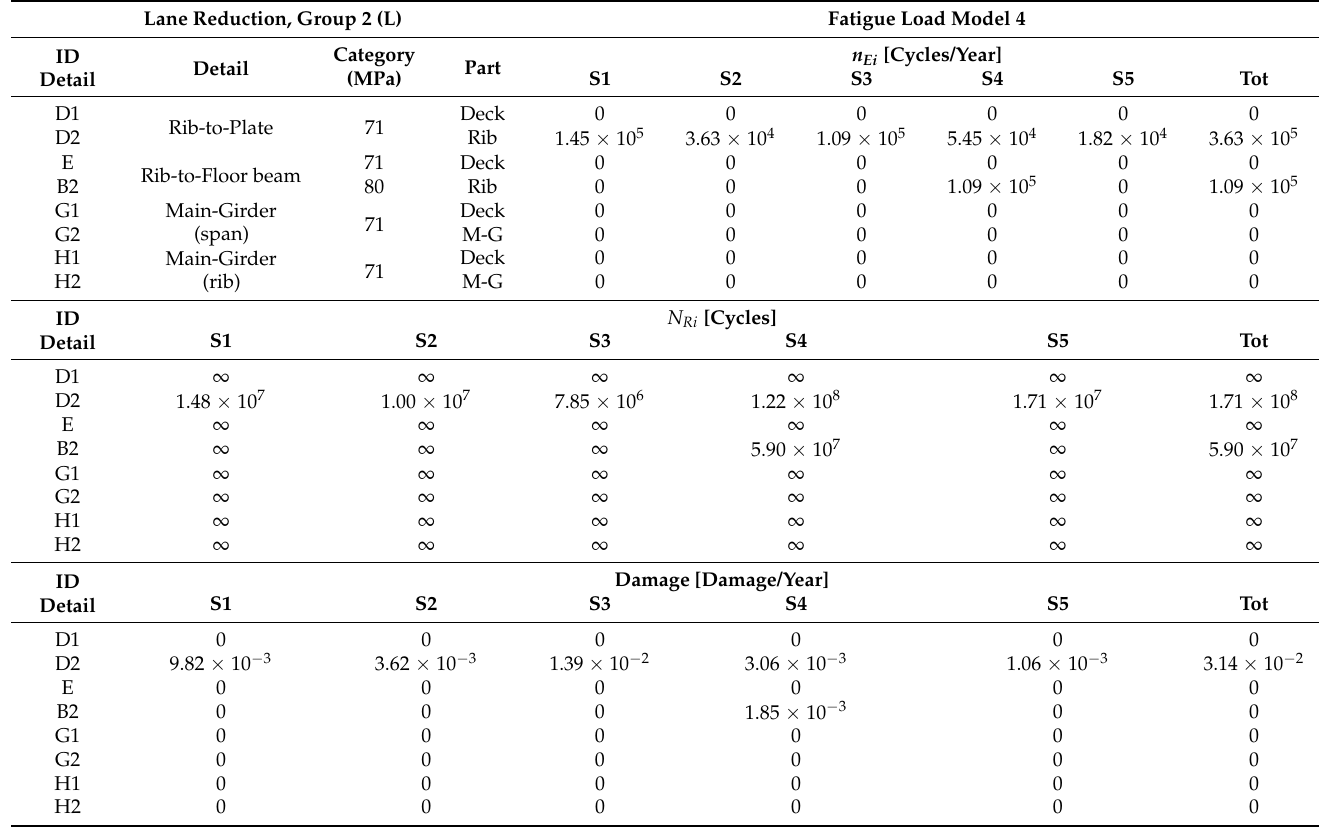
Table 12. Yearly fatigue damage accumulation—Group 2(L), with the additional New Jersey barriers and lane reduction since 2019.